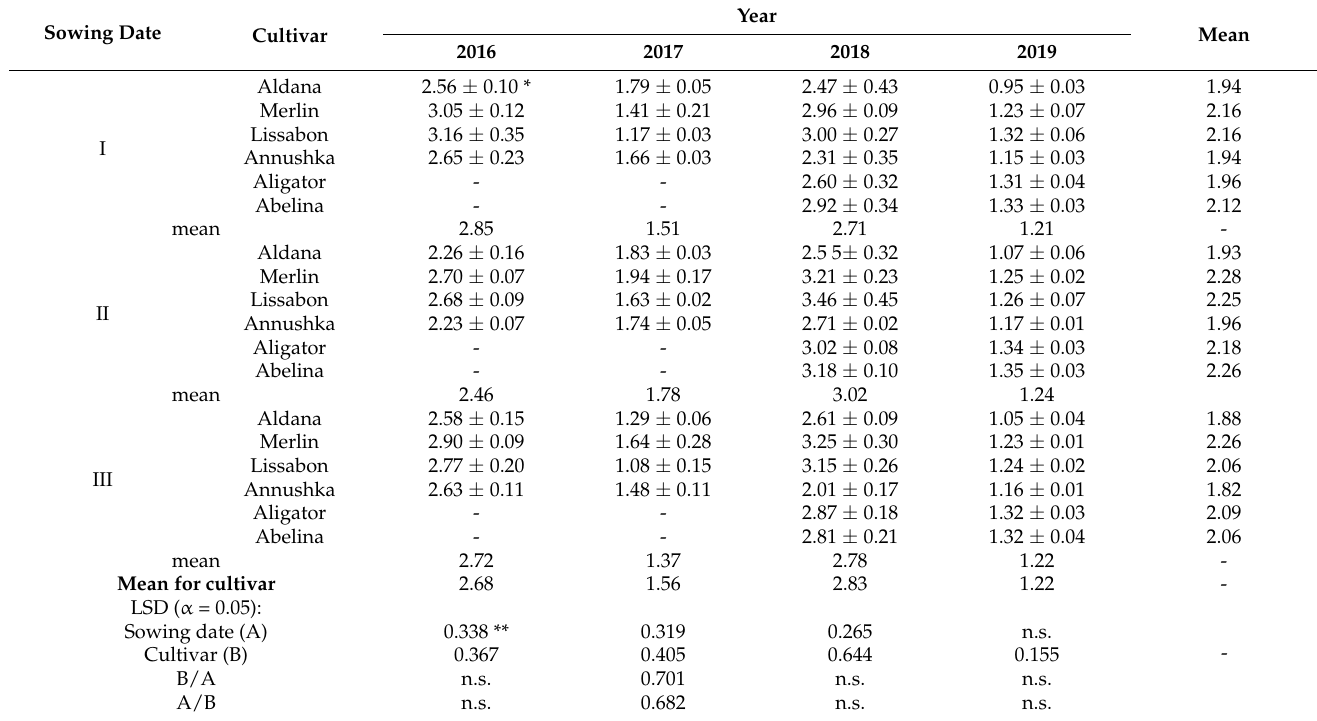
Table 3. Yield of soybean seeds depending on cultivar and sowing date (t ha − 1 ).